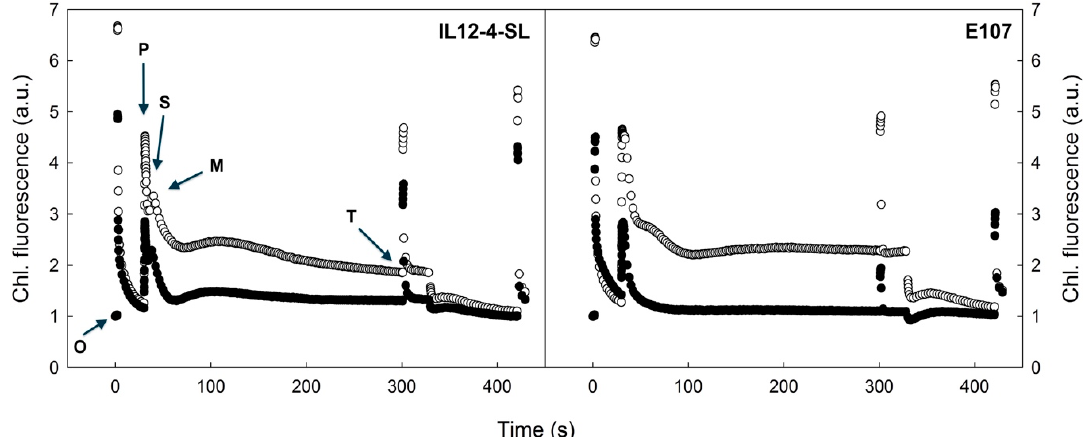
Figure 3. The effect of heat shock (60 min at 45 °C) on the shape of slow Kautsky kinetics in tomato plants. Non-treated controls are indicated by open symbols ( ), heat shock-treated leaves by solid symbols ( • ). Less sensitive (IL12-4-SL) and substantially sensitive genotypes (E107) are presented. The curves are means of at least 4 replicates (leaves). Data are normalized to background chlorophyll fluorescence (F 0 ). The chlorophyll fluorescence levels: O, fluorescence minimum; P, fluorescence peak; S, semi-steady state; M, fluorescence maximum; T, terminal steady state are indicated.